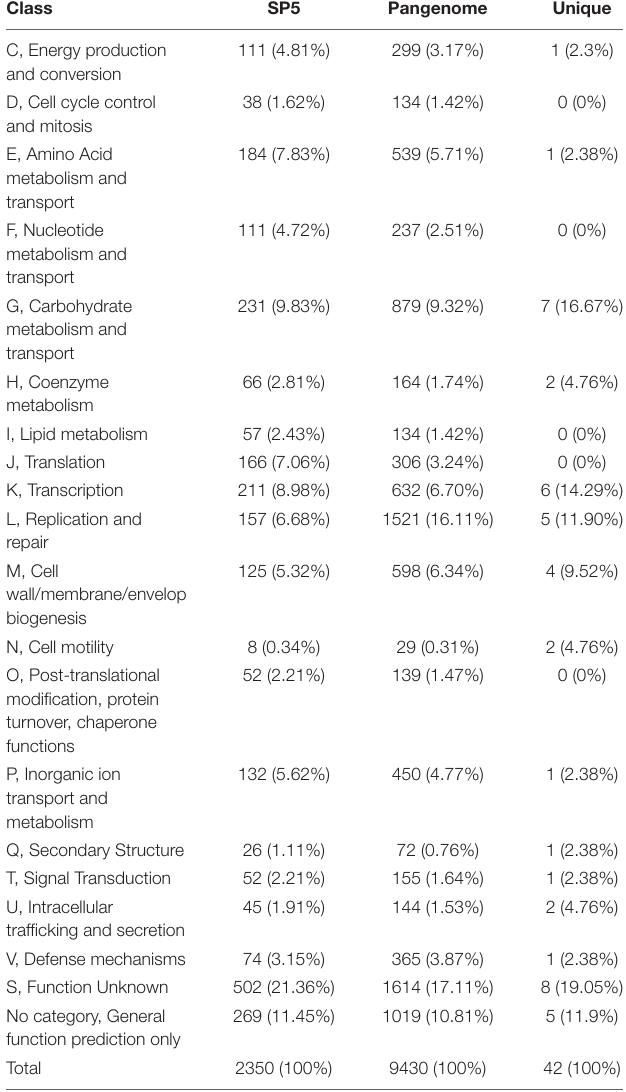
TABLE 2 | Categorization of genes (SP5, Pangenome, SP5 unique genes) to clusters of orthologous genes